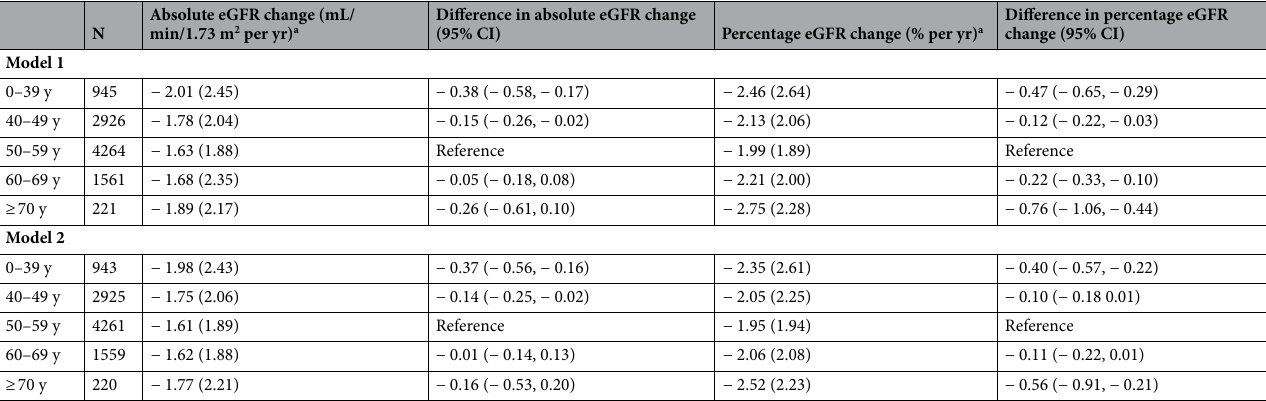
Table 3. Annual change in eGFR according to known age-of-onset of diabetes. Model 1: adjusted for age, sex, race and education. Model 2: Model 1 + smoking status at baseline, family history of cardiovascular disease (CVD), CVD history at baseline, diabetes duration, body mass index, blood pressure levels, use of renin– angiotensin–aldosterone system blockers, glycated haemoglobin level, serum lipid levels, and baseline urine albumin/creatinine, ratio. Baseline eGFR is not included in the covariate set, as it is already present in the joint longitudinal-survival model specification. eGFR estimated glomerular filtration rate, y years. a Data are mean (standard deviation).